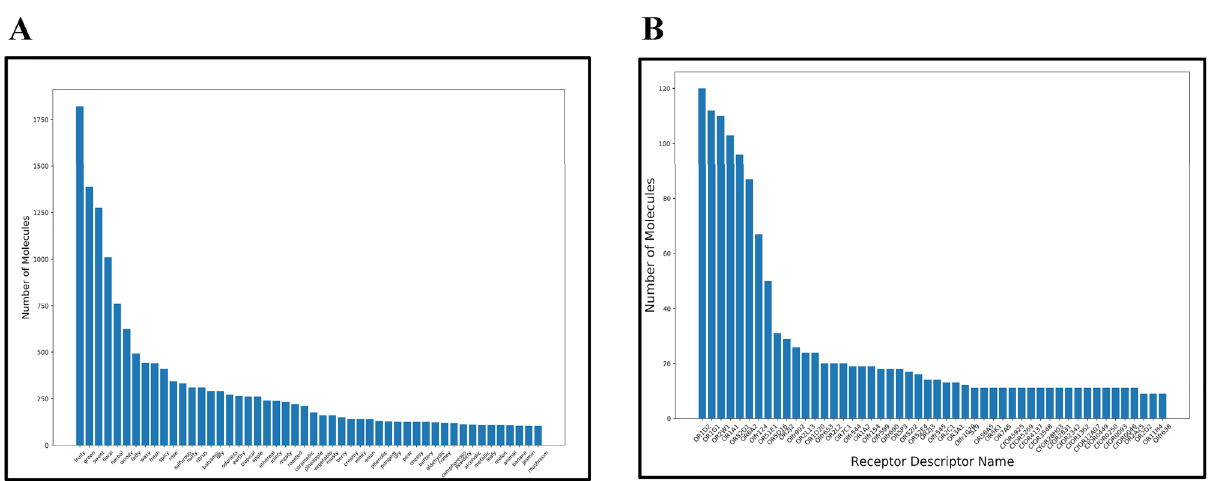
Figure 1. ( A ) Occurrence of compounds related to odors. ( B ) Occurrence of compounds related to olfactory